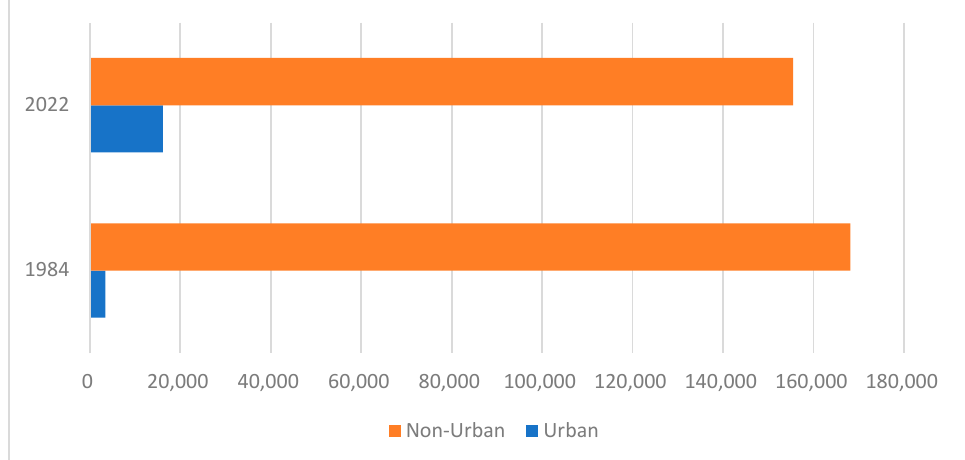
Figure 11. The urban sprawl for Hail between 1984 and 2022.